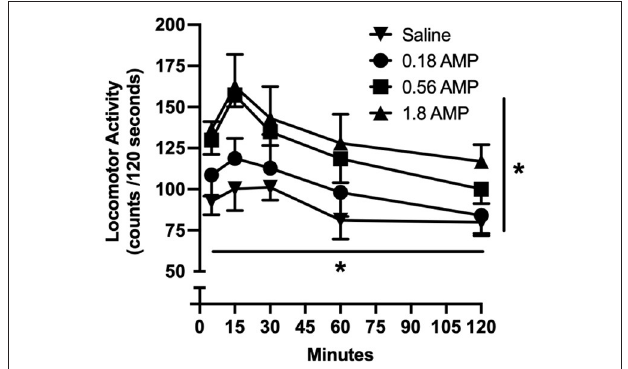
FIGURE 1 | Time-course effects of acute doses of d -amphetamine on locomotor activity. Vertical axis reflects locomotor activity expressed as raw activity counts over 120-s observation period. Horizontal axis reflects time after administration in minutes. All data points reflect the mean of 5–6 rats. Vertical lines represent the SEM; where not indicated, the SEM fell within the data point. Asterisk with horizontal line indicates significant effect of time. Asterisk with vertical line indicates significant effect of amphetamine dose.